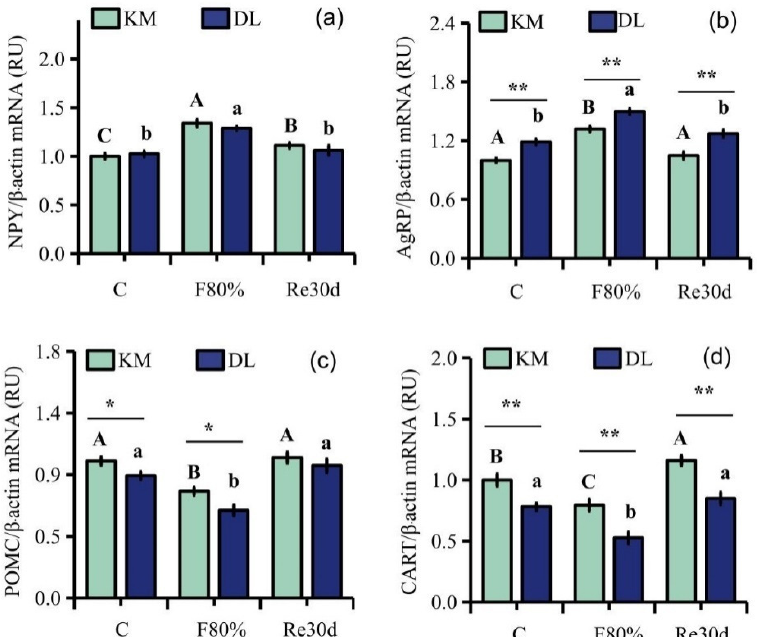
Figure 2. Gene expression levels of NPY ( a ), AgRP ( b ), POMC ( c ), and CART ( d ) in the hypothalamus of E. miletus under food restriction. Different letters denotesignificant differences among treatments in the same region, capital letters refer to the Kunming region, and lowercase letters refer to the Dali region. * p < 0.05, ** p < 0.01 Kunming versus Dali on the same day.